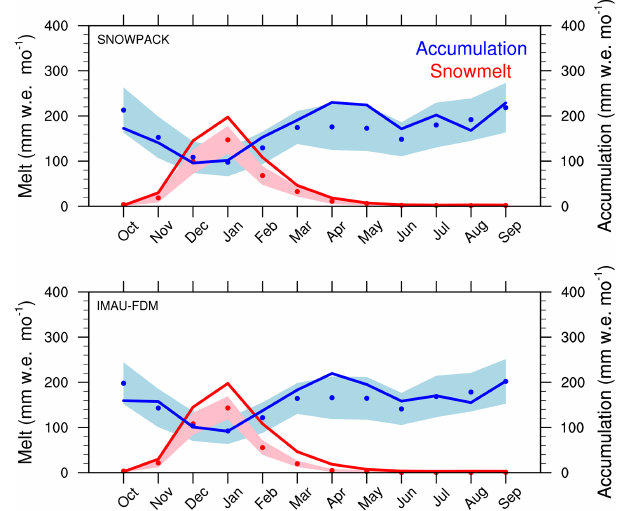
Figure 13. Monthly climatological (1979–2016) average surface melt production (left axis, red) and accumulation (right axis, blue) for years of > 25% increases in perennial firn liquid water content. The solid lines show the monthly averages of formation years, while the dots show the monthly averages of all years in the 1979–2016